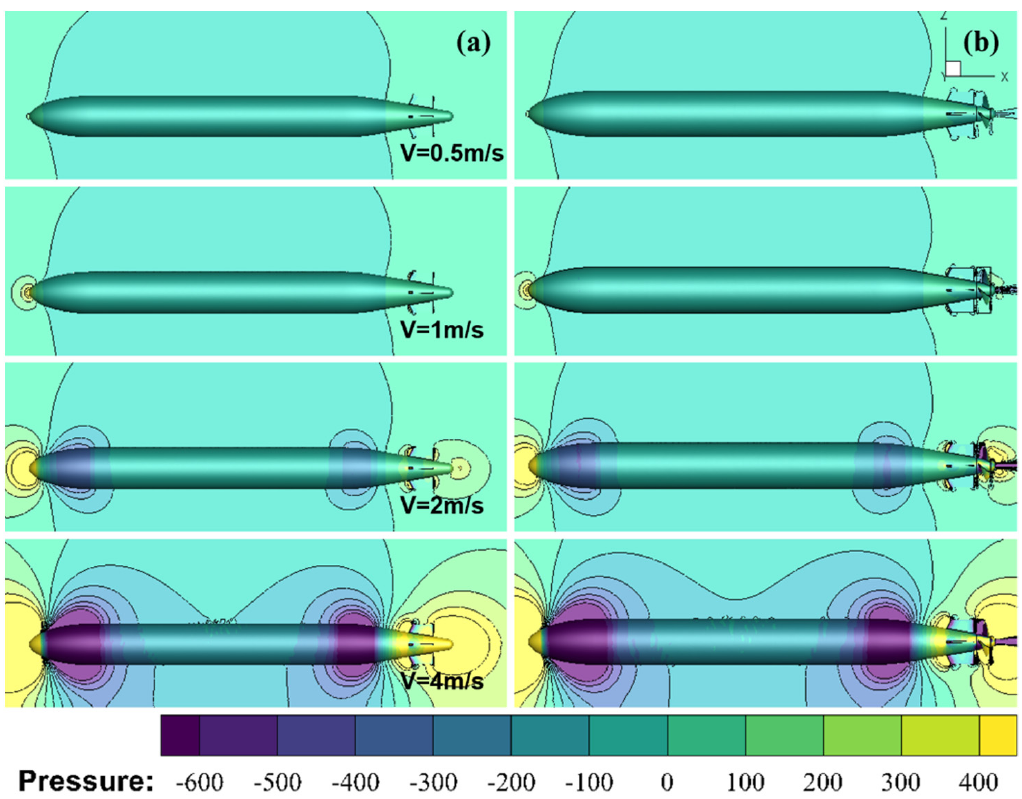
Figure 15. The pressure clouds at the bare UUV as shown columns ( a ) and self − propelled UUV as shown columns ( b ) at cross − section a.